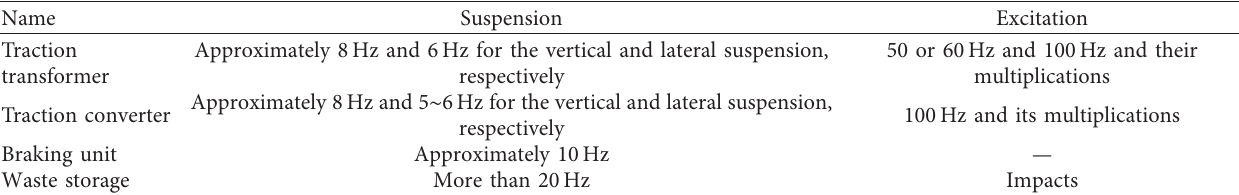
Figure 20: Spectrums of the vertical acceleration on the (a) CBSE traction converter and (b) CB. Table 2: Frequency characteristics of the